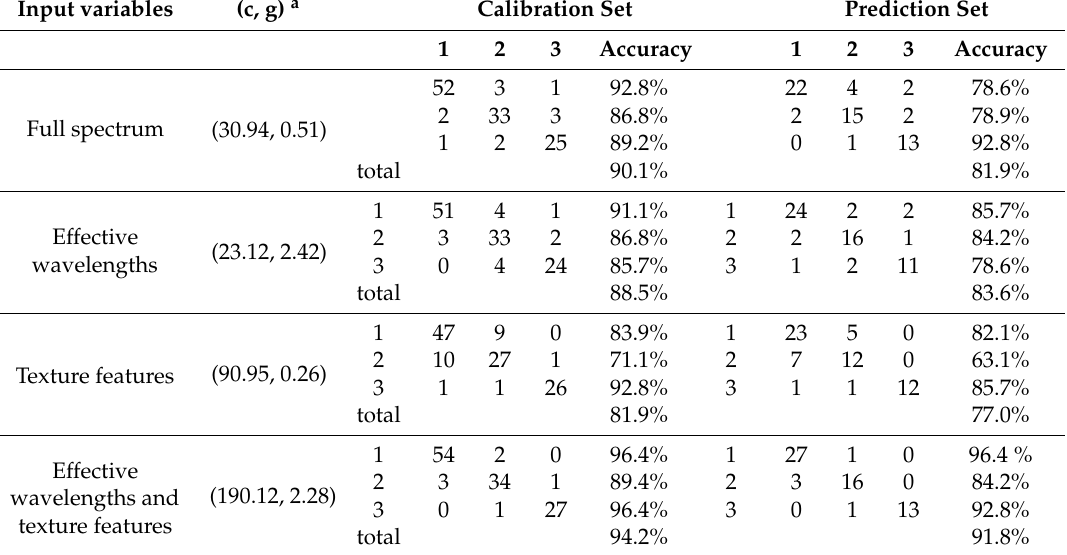
Table 1. Classification results for soil types using SVM models established based on different input variables.